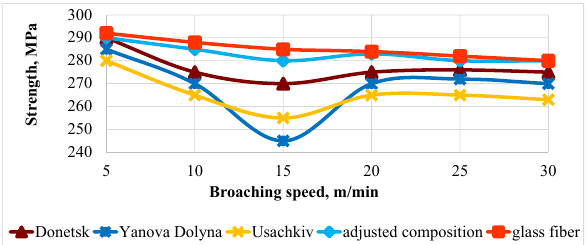
Fig. 6. The effect of melt cooling rate on the strength of basalt